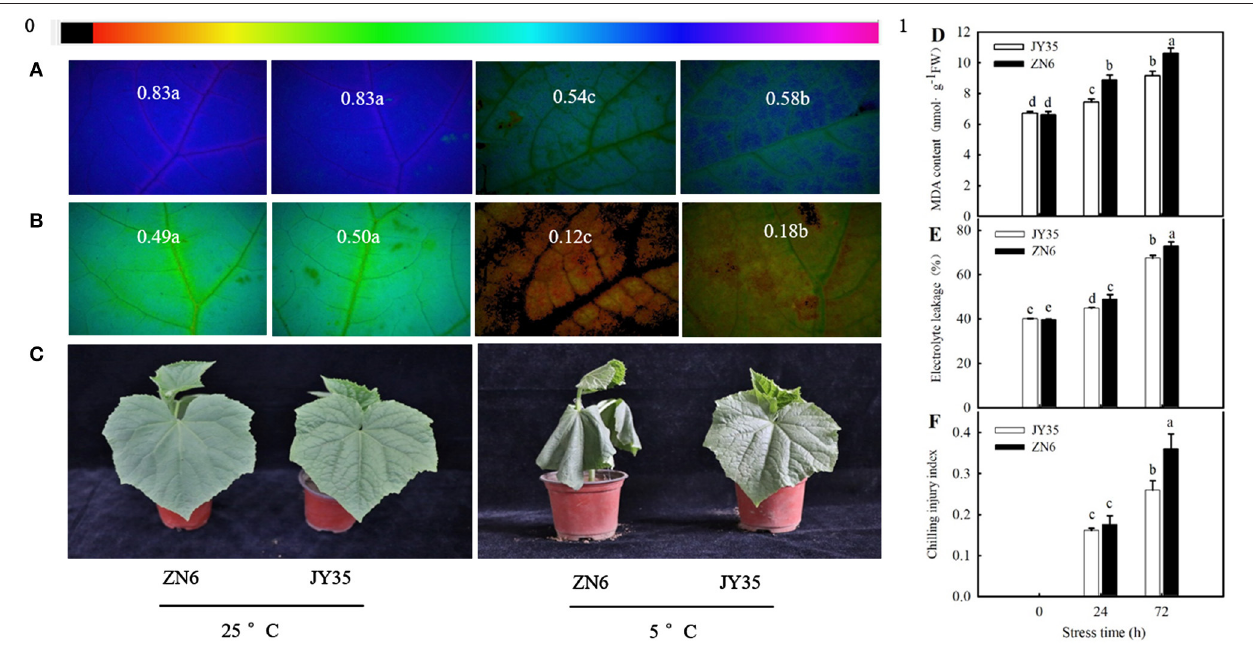
FIGURE 2 | Comparison of cold tolerance in the two different cucumber varieties. Images of (A) F v / F m and (B) Φ PSII , respectively. The false color code depicted at the top of the image ranging from 0 (black) to 1 (purple) represents the degree of photoinhibition at photosystem II (PSII). (C) Seedling phenotype. Three-leaf stage seedlings were treated at 5 ◦ C for 24h; (D) Malondialdehyde (MDA) accumulation, (E) Electrolyte leakage (EL) rate, and (F) Chilling injury index (CI), respectively. Seedlings were exposed to 5 ◦ C for 72h. Data are represented as mean ± SD ( n = 3). Different letters indicate a significant difference between samples according to Duncan’s new multiple range test ( p < 0.05).